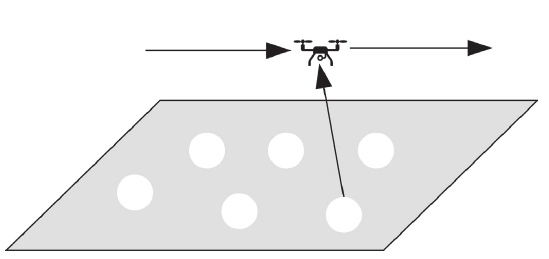
Figure 1: System